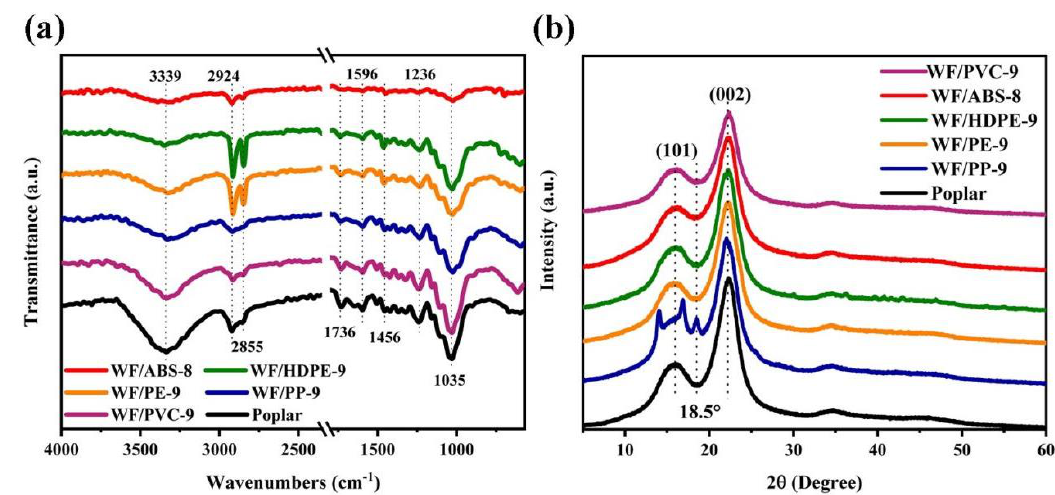
Figure 8. ( a ) ATR FT-IR spectra of WPS and poplar. ( b ) XRD patterns of WPS and poplar.